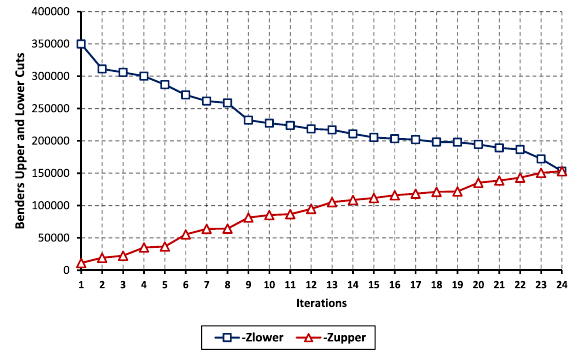
Fig. 10 Benders ’ decomposition convergence diagram